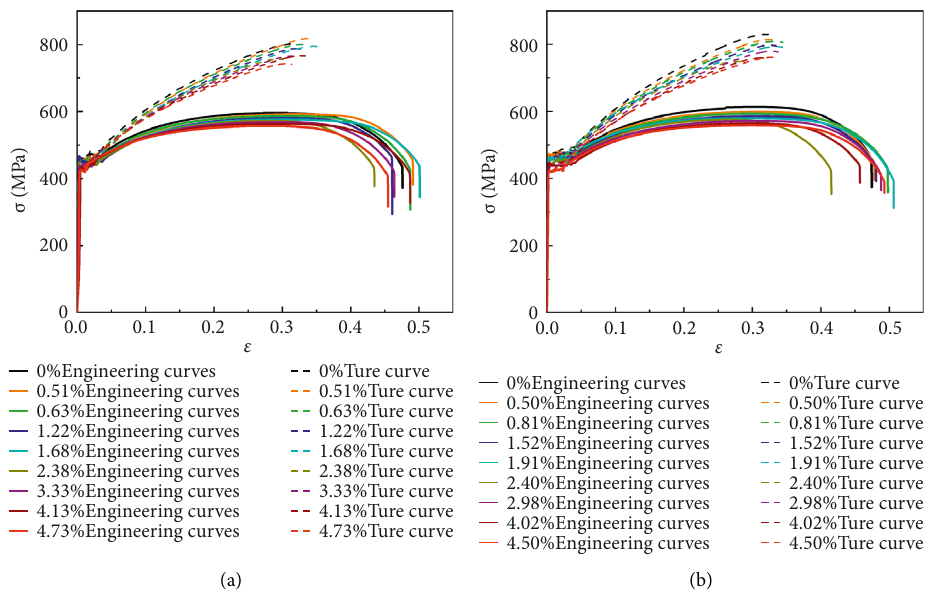
Figure 17: True stress-strain curves. (a) Carbon steel. (b) Weathering